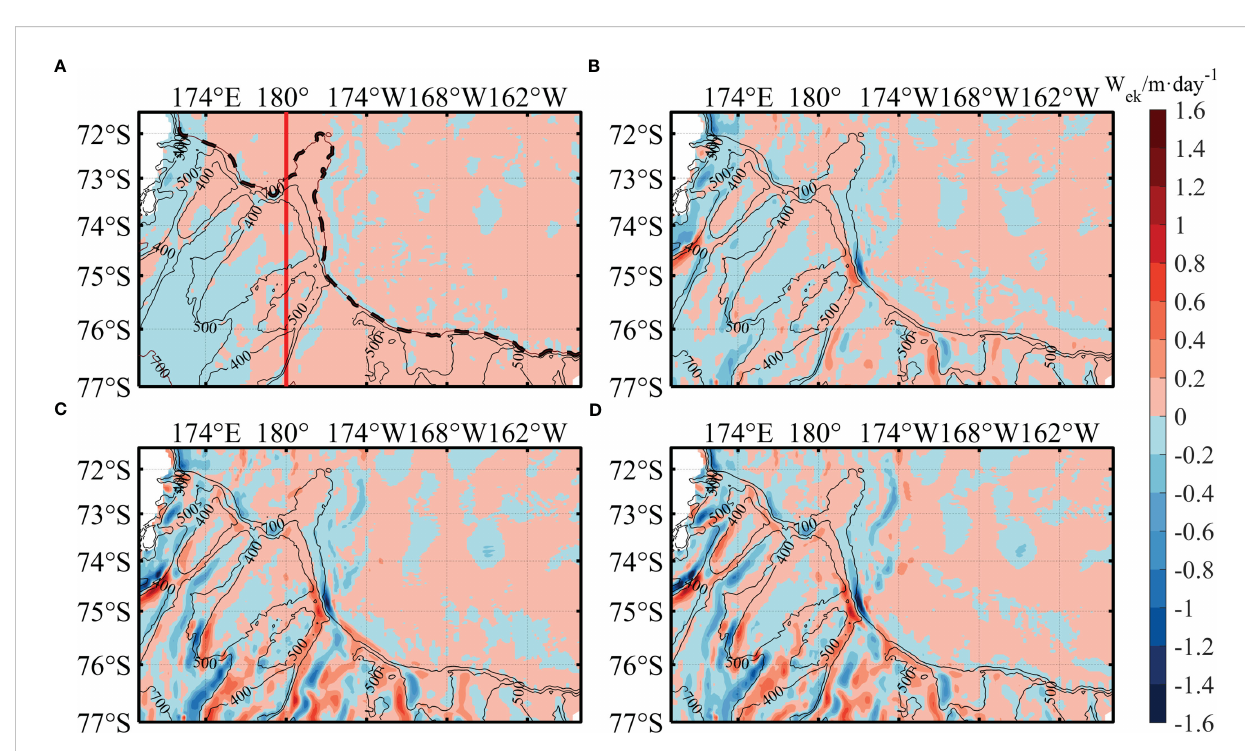
FIGURE 8 (A – D) Seasonal average Ekman pumping velocities W ek (positive: upward) in DJF, MAM, JJA, and SON, respectively. Thin gray lines represent isobaths, the black dash line is the 700-m isobath representing the shelf break, and the red solid line at the 180° longitude is arbitrarily chosen to divide the western and eastern parts of the Ross Sea predominated by downwelling and upwelling. DJF, December – January – February; MAM, March – April – May; JJA, June – July – August; SON, September – October –